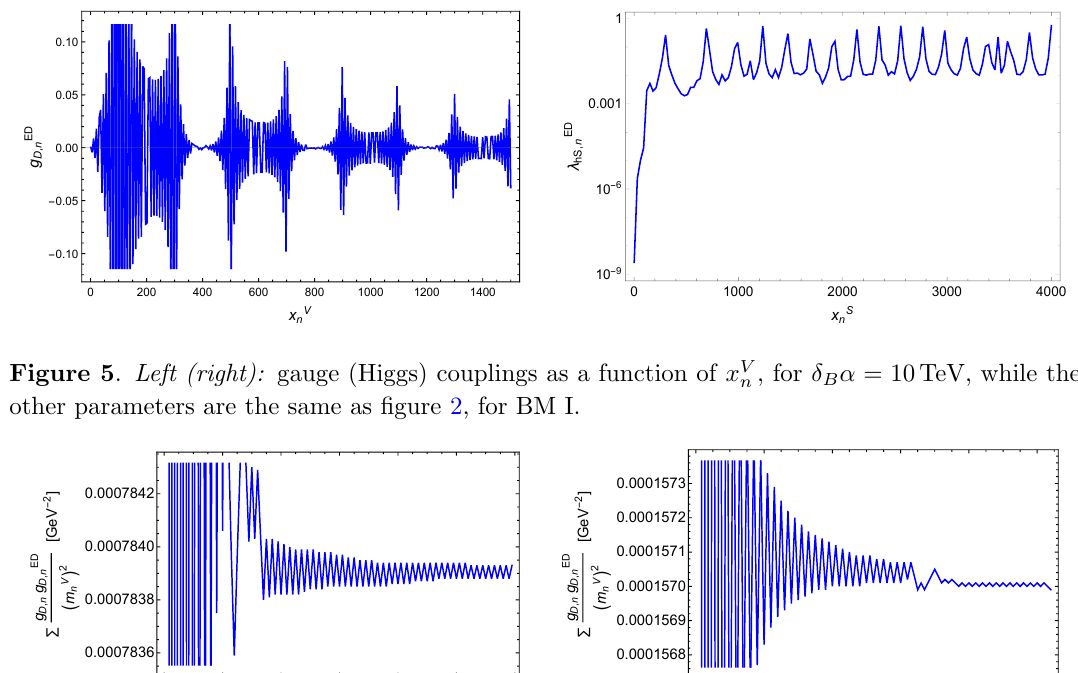
Figure 6 . Sum of the (cid:12)rst n terms in eq. (3.15) (the behavior is qualitatively the same for the sum in eq. (3.16)), for BM I (left) and BM II (right). For the other BM points the pattern is similar. It can be seen that these sums converges quickly, being relatively constant after n (cid:24) 50. Small jumps are due to round o(cid:11) errors in the